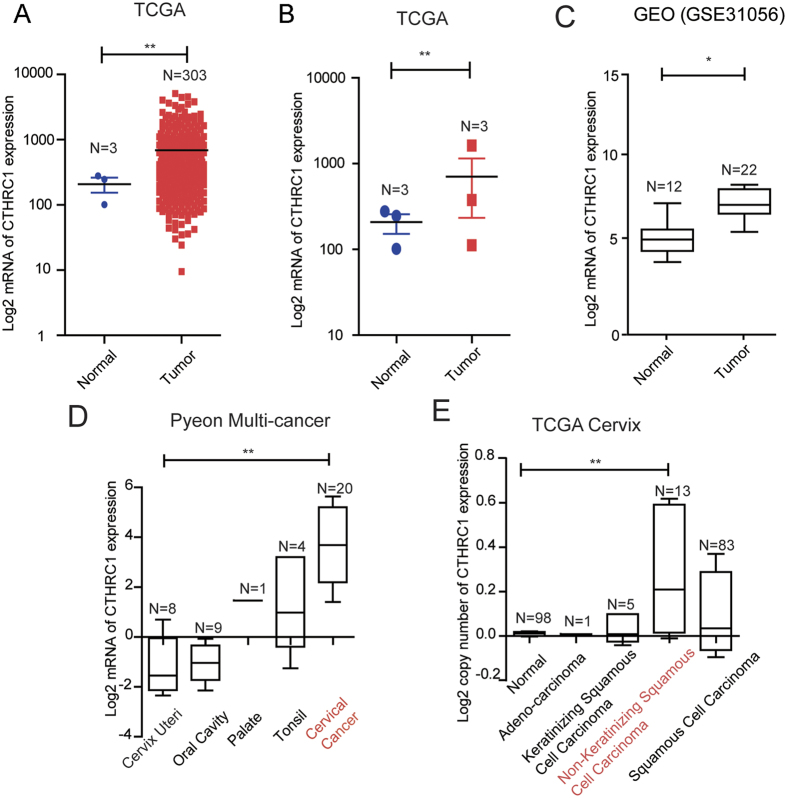
CTHRC1 expression was significantly up-regulated in cervical cancers.(A) The mRNA expression of CTHRC1 is upregulated in tumor tissues compared with the normal tissues revealed using the TCGA dataset. (B) The mRNA expression of CTHRC1 is upregulated in three matched tumor and non-tumor tissue revealed using the TCGA dataset. (C) CTHRC1 expression in the normal and tumor tissues revealed by the GSE31056 dataset. (D) The mRNA expression of CTHRC1 was analyzed in different cancers in Oncomine datasete about 42 women. (E) The copy number of CTHRC1 expression in different tissues was analyzed in TCGA dataset about 200 women.